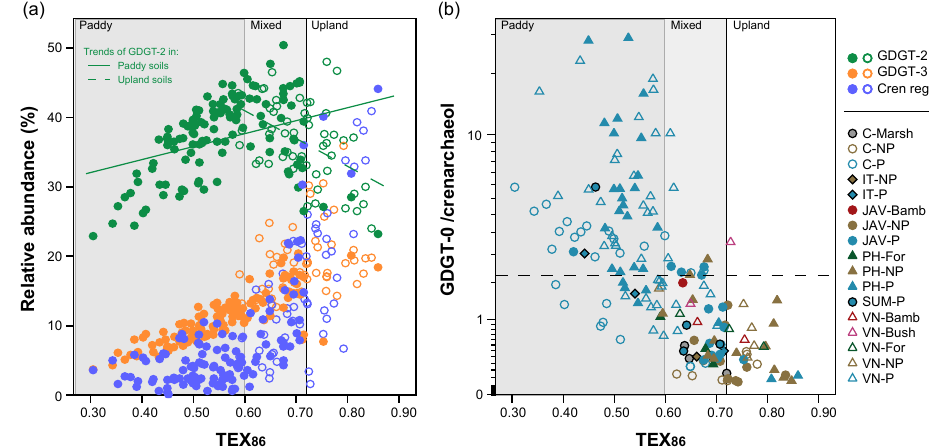
Figure 3. Cross plots showing (a) the relative abundance (% of the sum of GDGT-1, GDGT-2, GDGT-3 and crenarchaeol regioisomer) vs. TEX 86 and (b) the relationship between the most abundant iGDGTs (GDGT-0 and crenarchaeol) and lower concentrated iGDGTs (GDGT-1, GDGT-2, GDGT-3, and crenarchaeol regioisomer) as TEX 86 . GDGT-0 / crenarchaeol >2 and TEX 86 <0.6 are diagnostic for methanogens. Two outliers from the Ifugao site (Philippines) with a GDGT-0 / crenarchaeol ratio>69 were excluded from the figure. Note the logarithmic scale for GDGT-0 / crenarchaeol ratios. The filled circles in (a) denote paddy soils and the non-filled circles denote upland, marsh, forest, bamboo and bushland